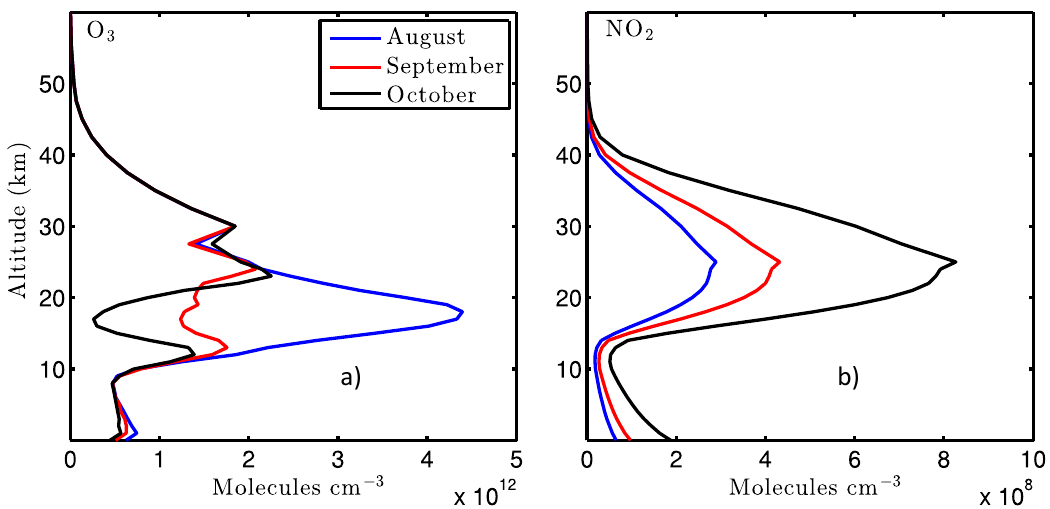
Figure 4. Vertical profiles of ( a ) O 3 and ( b ) NO 2 concentrations at Belgrano II station during the months of August (blue), September (red) and October (black).